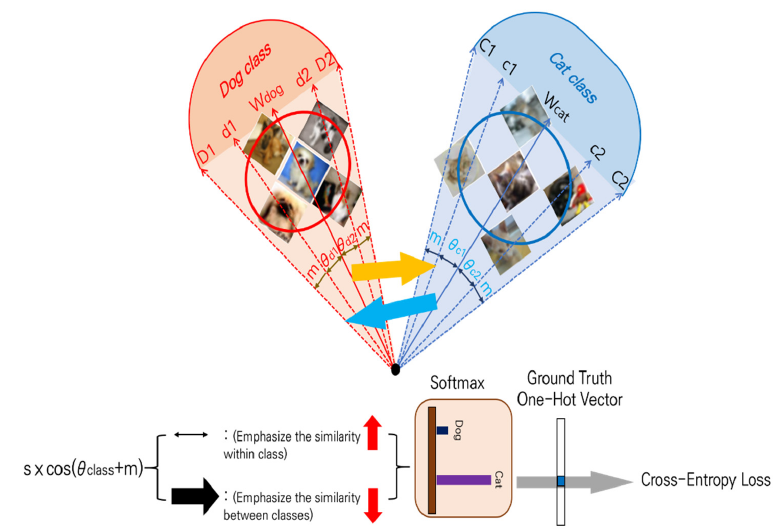
Figure 4. Configuration of the ArcFace loss